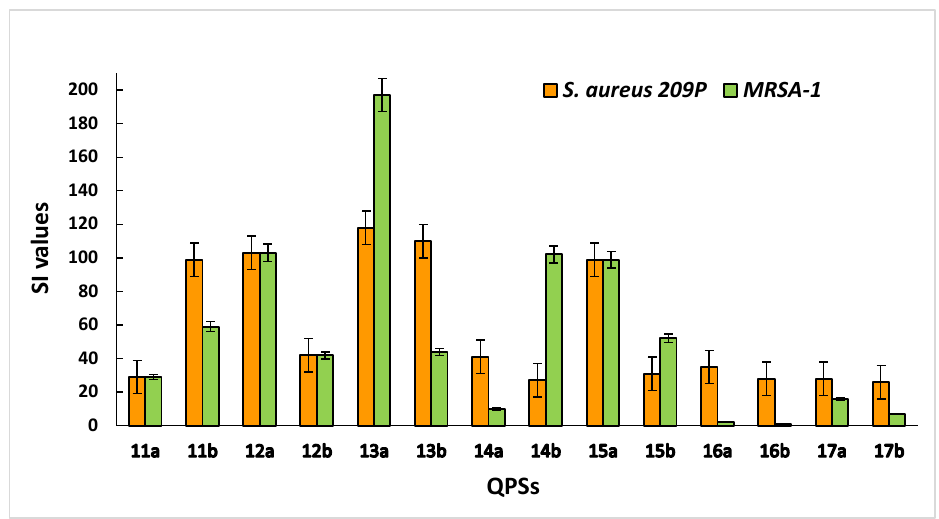
Figure 3. Selectivity of QPSs for bacteria ( S. aureus 209 P and MRSA-1 ) compared to Chang liver cells.